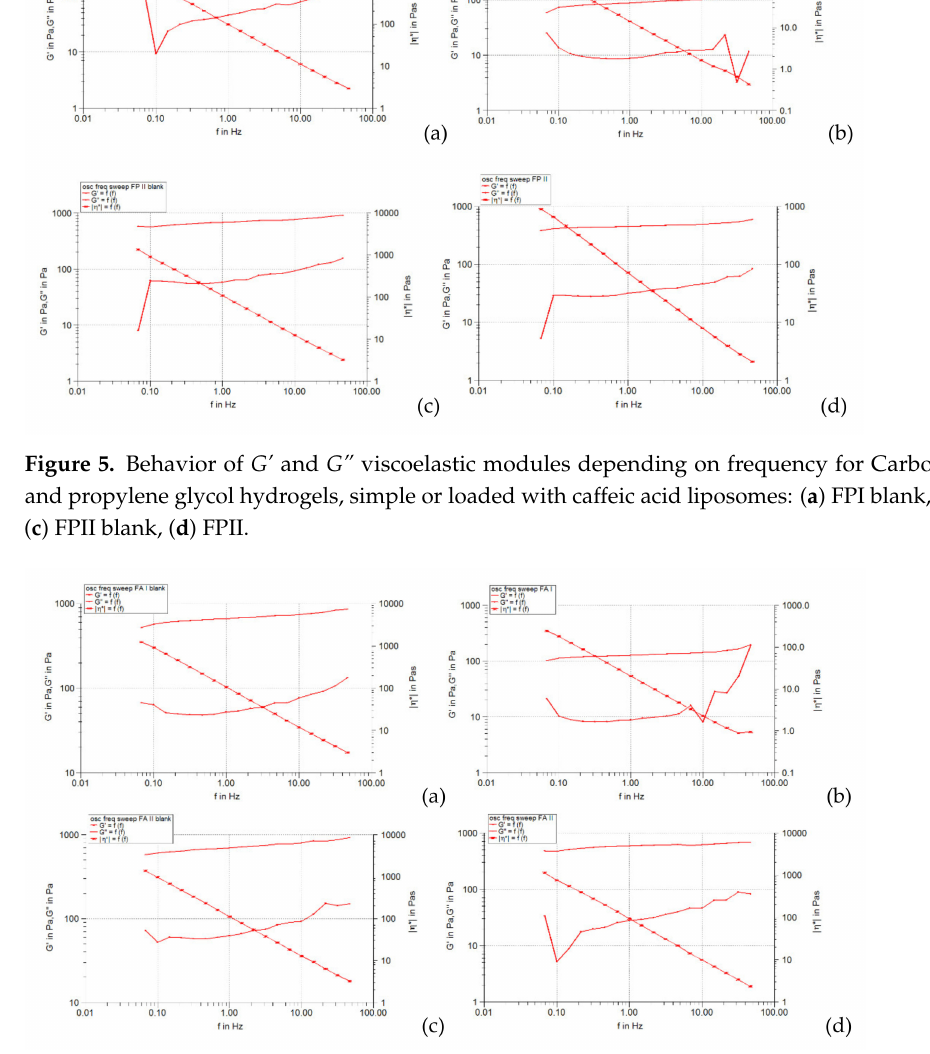
Figure 6. The behavior of G’ and G” viscoelastic modules depending on frequency for Carbopol 940 and isopropyl alcohol, simple or loaded with caffeic acid liposomes: ( a ) FAI blank, ( b ) FAI, ( c ) FAII blank, ( d )